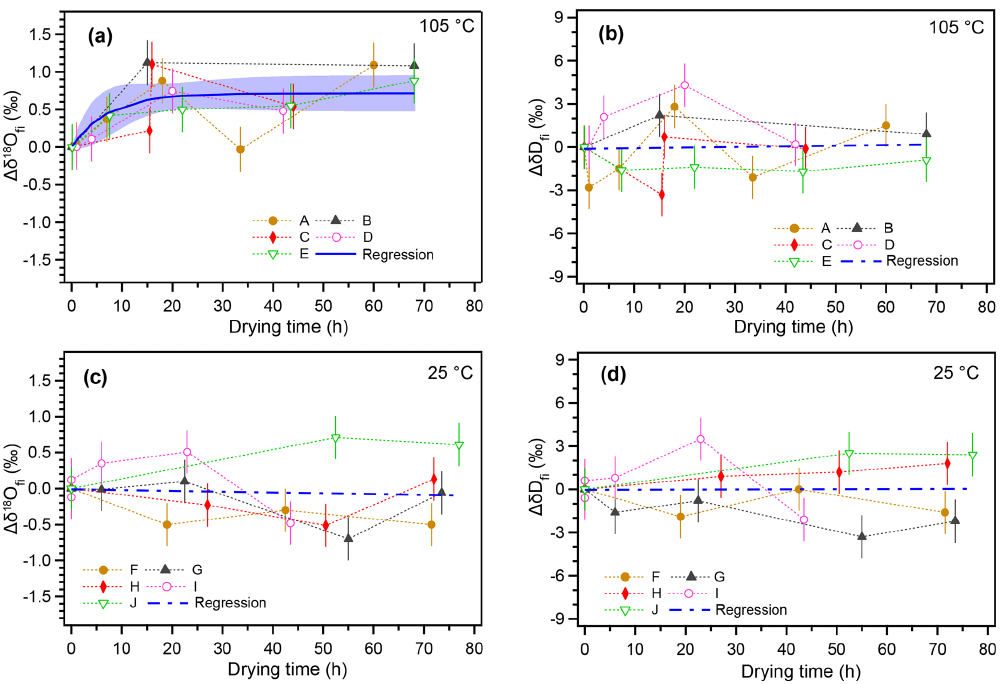
Figure 2. Changes in isotopic compositions of inclusion water with increasing drying time. (a) Changes in the δ 18 O value of inclusion water from the initial value ( (cid:49)δ 18 ) with time under 105 ◦ C heating. Time on the x axis indicates drying time in addition to the standard 17h fi( t ) drying process at room temperature. (b) The same as (a) but for δ D fi . (c) Changes in the (cid:49)δ 18 value over time at room temperature (25 ◦ C). fi( t ) (d) The same as (c) but for δ D fi . The error bar of the data point represents the analytical reproducibility (1 σ ). The regression curve (blue) = A (1 − exp( − kt ))) ( A = 0 . 71: k = 0 . 14). The in panel (a) was calculated with IGOR (WaveMetrics Inc.) software to fit a function ( (cid:49)δ 18 fi( t ) blue shade indicates the 95% confidence interval. Blue dashed lines in panels (b) – (d) indicate linear regression lines (the correlations are